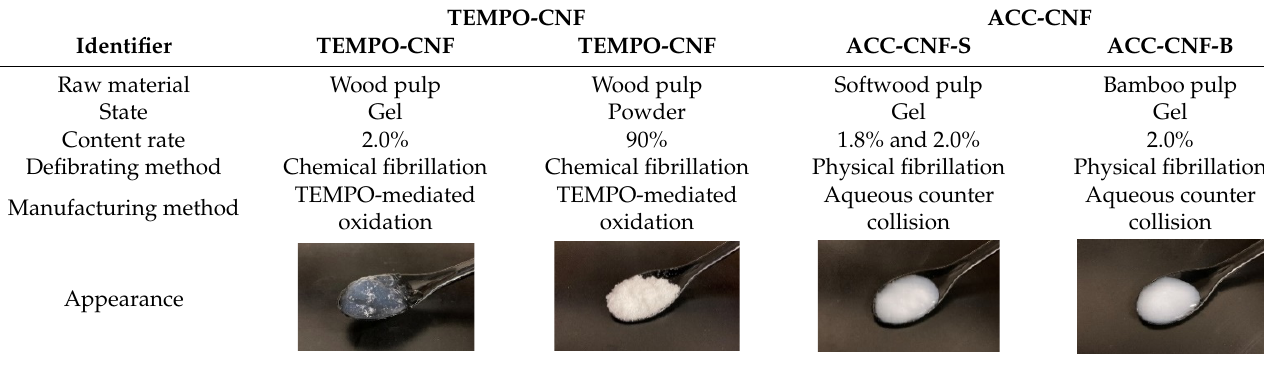
Table 1. Cellulose nanofibre used for tests.